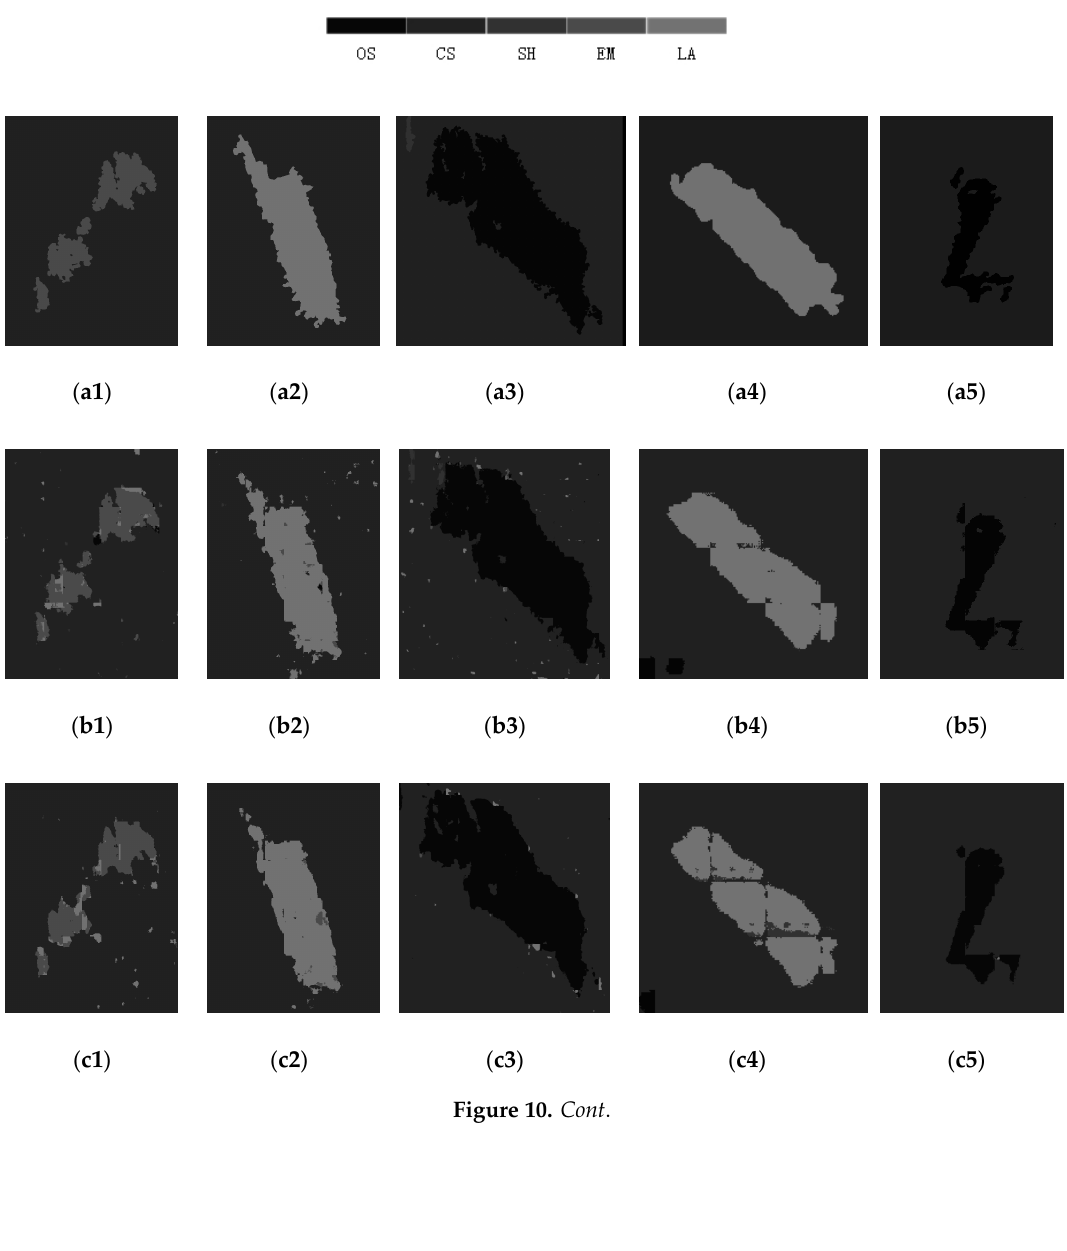
Figure 9. The results of dark spots area verified by polarized parameters, 1-3 in each group